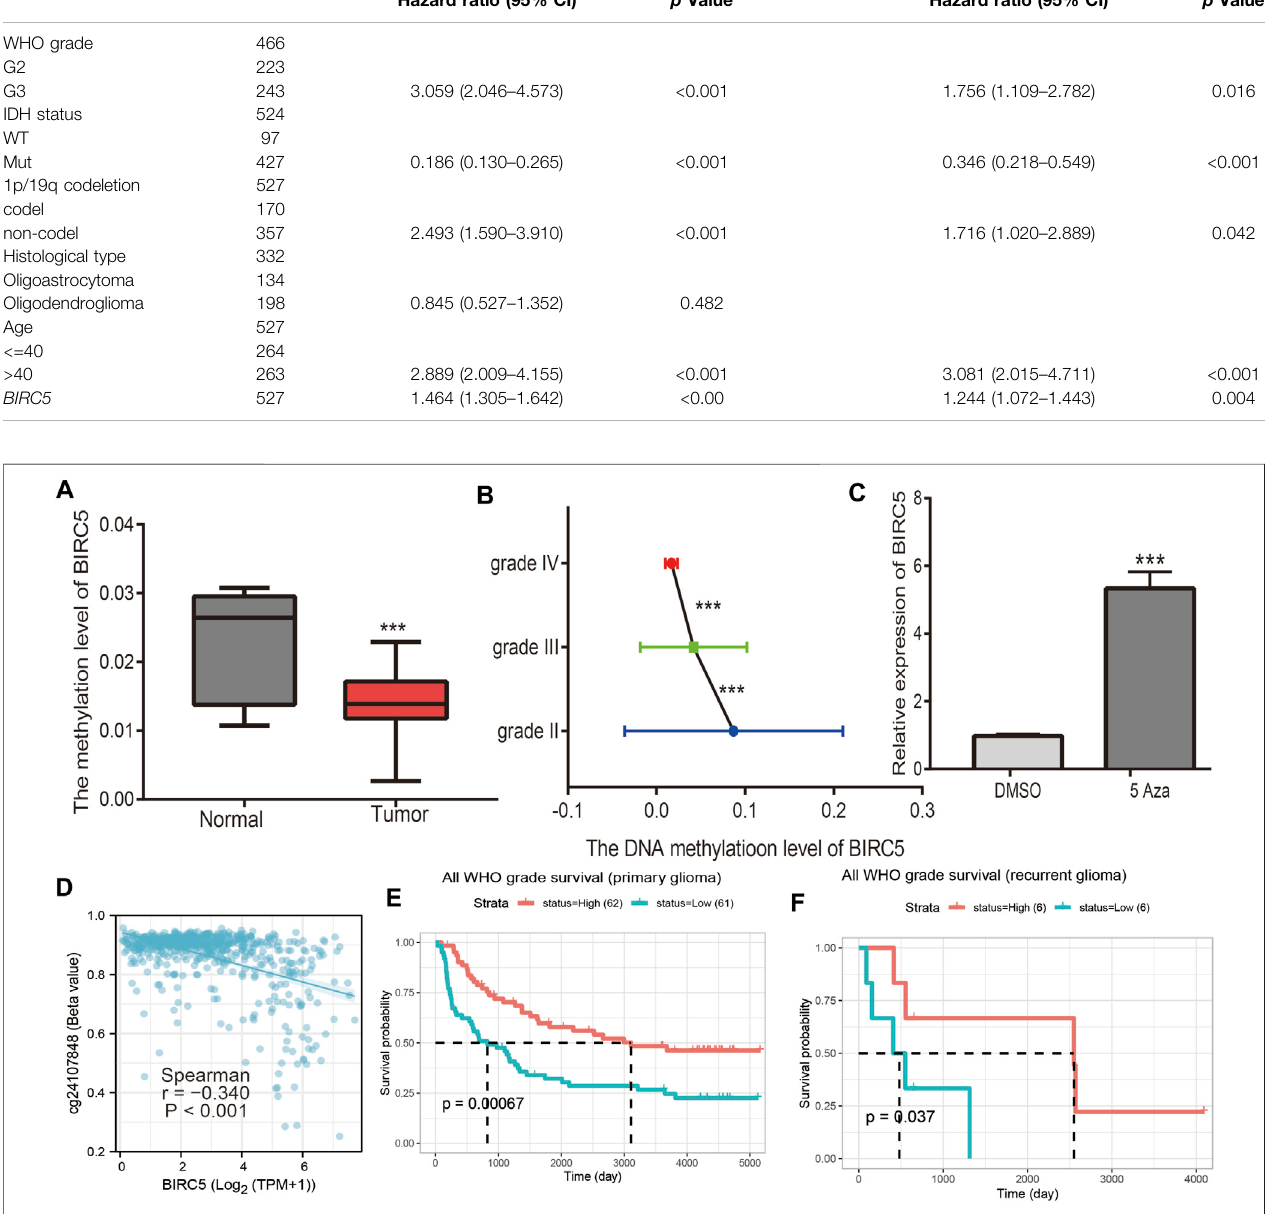
FIGURE4| Analysisofthe BIRC5 methylationlevel. (A) TheDNAmethylationlevelof BIRC5 inLGG. (B) TheDNAmethylationlevelof BIRC5 indiversetumorgrades of LGG based on the CGGA dataset. (C) The expression of BIRC5 in U251 cells after using 5-AZA treatment was examined by qRT-PCR assay. (D) The correlation betweenDNAmethylationand BIRC5 expressioninlowgradegliomabyPearson ’ scorrelation. (E,F) Theprognosisformethylationlevelof BIRC5 ingliomabasedonthe CGGA dataset.